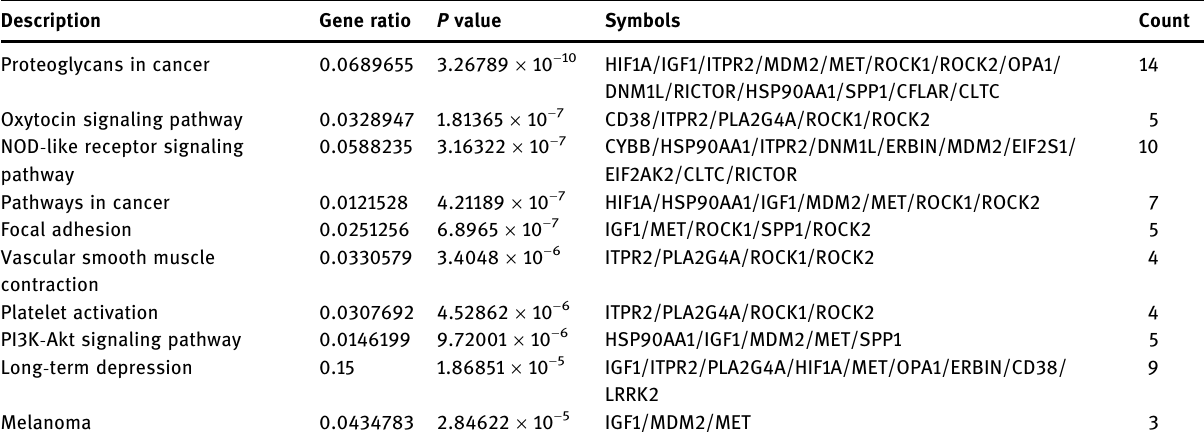
Table 1: KEGG analysis of ARDEGs in PAH ( top ten listed )